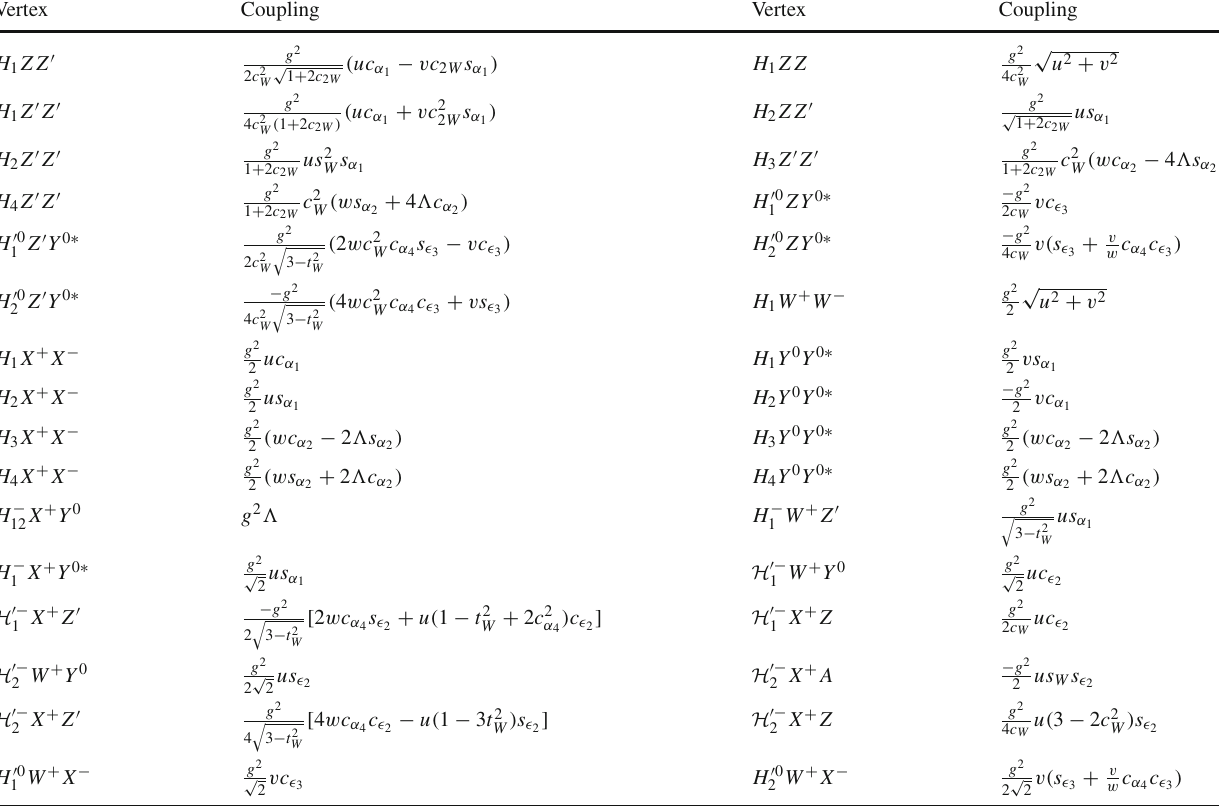
Table 5 The interactions of a scalar with two gauge bosons Vertex Coupling Vertex